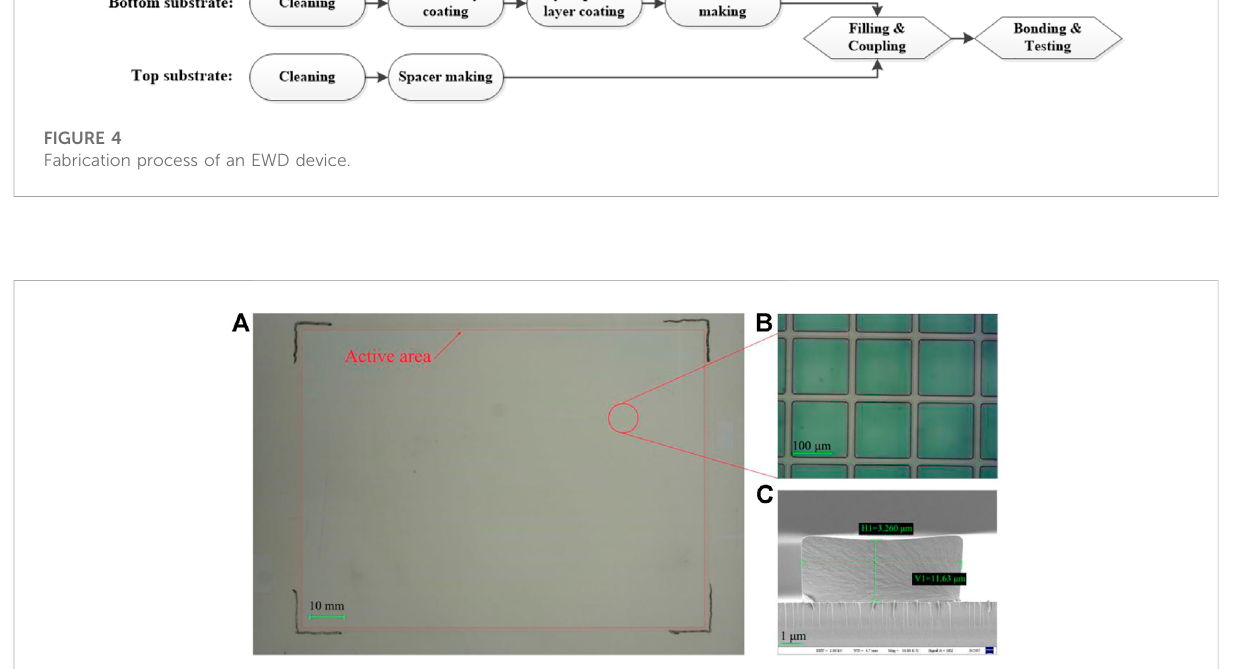
FIGURE 5 The as-prepared bottom substrate. (A) macro photo of bottom substrate was taken by a crammer, and (B) the pixel wall structure was taken underthemicroscope, the pixel size was184*184 μ m. (C) Morphology of thepixel wall undertheSEM, Pixelwall width was11.63 μ m and height